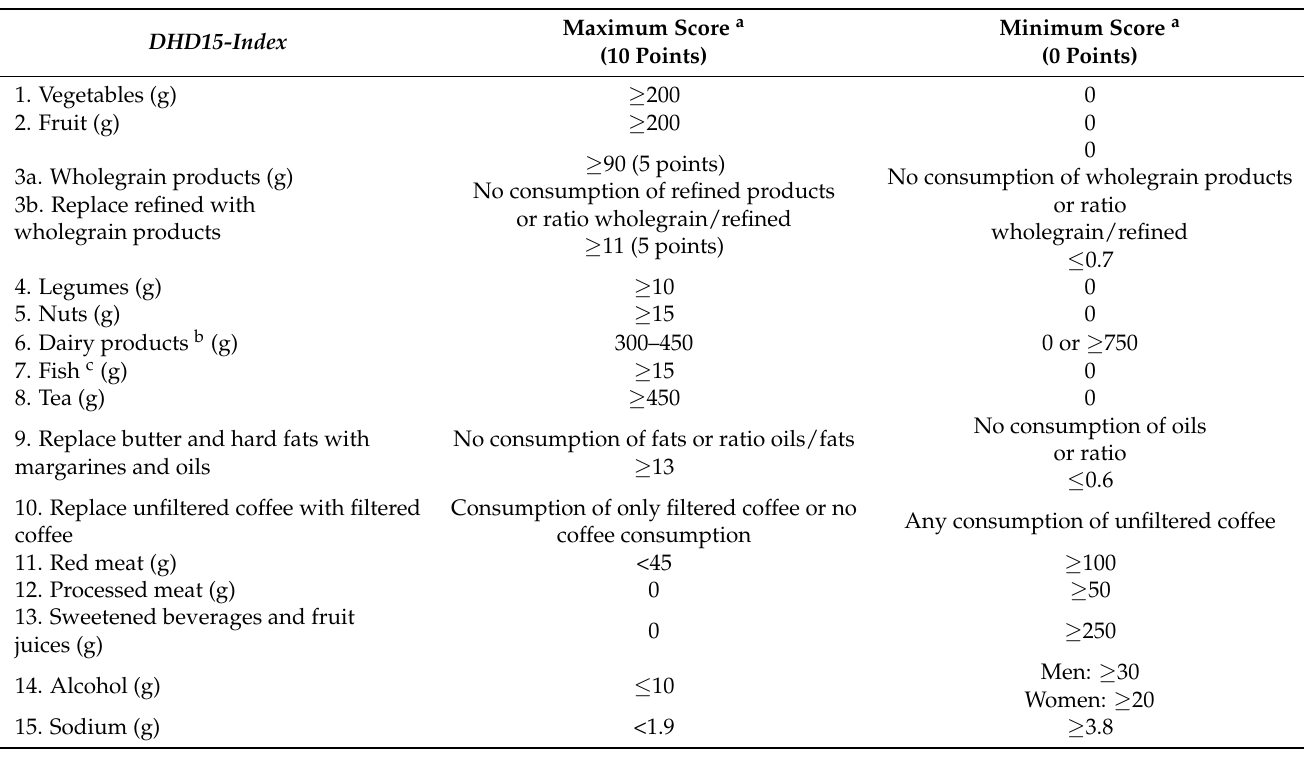
Table A1. Components and scoring criteria of the Dutch Healthy Diet index 2015 (DHD15-index), cited from Looman et al., 2017 [19].